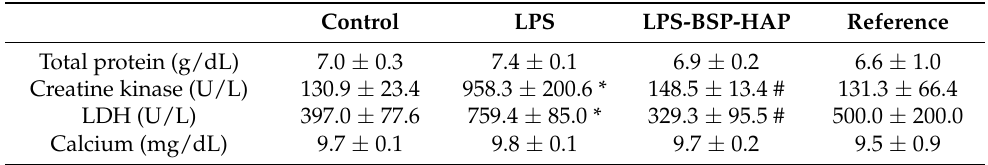
Table 3. The blood biochemical analysis serum concentration of total protein (TP), creatine kinase (CK), lactate dehydrogenase (LDH) and calcium (Ca) ( n = 6, * p < 0.05 compared with control; # p < 0.05 compared with LPS). Reference: Charles River Laboratories, CD ® IGS Rat Model Informa- tion